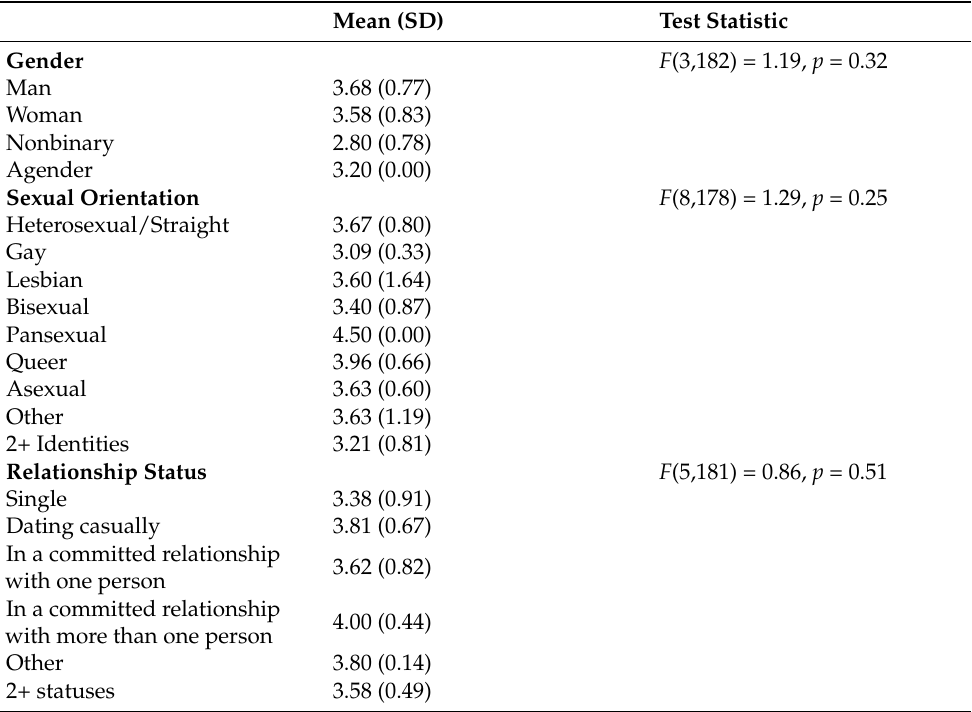
Table 1. Body appreciation scores by demographic